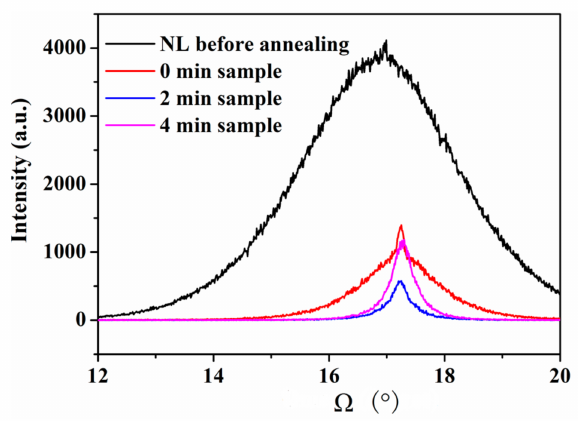
Figure 5. The rocking curves of (002) plane of GaN NL before and after 0, 2 and 4-min annealing.